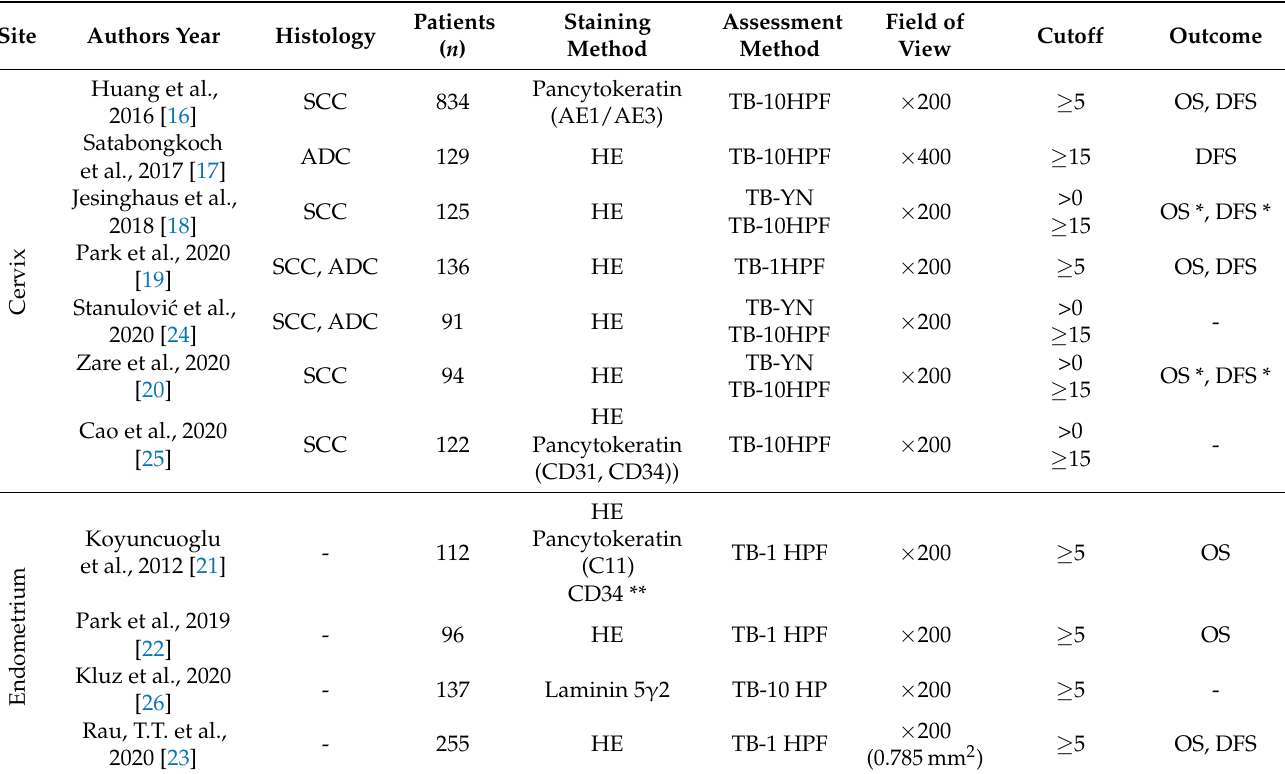
Table 1. Main characteristics of all gynecological cancer studies included in the